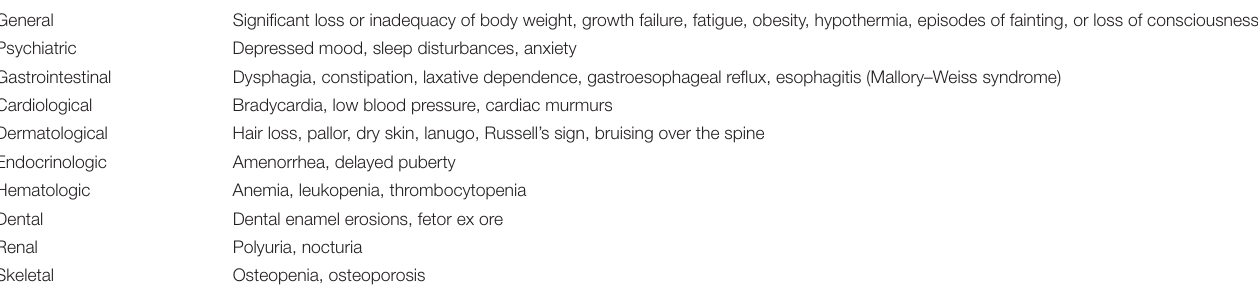
TABLE 2 | Major health complaints, symptoms, and signs in adolescents with eating disorders.